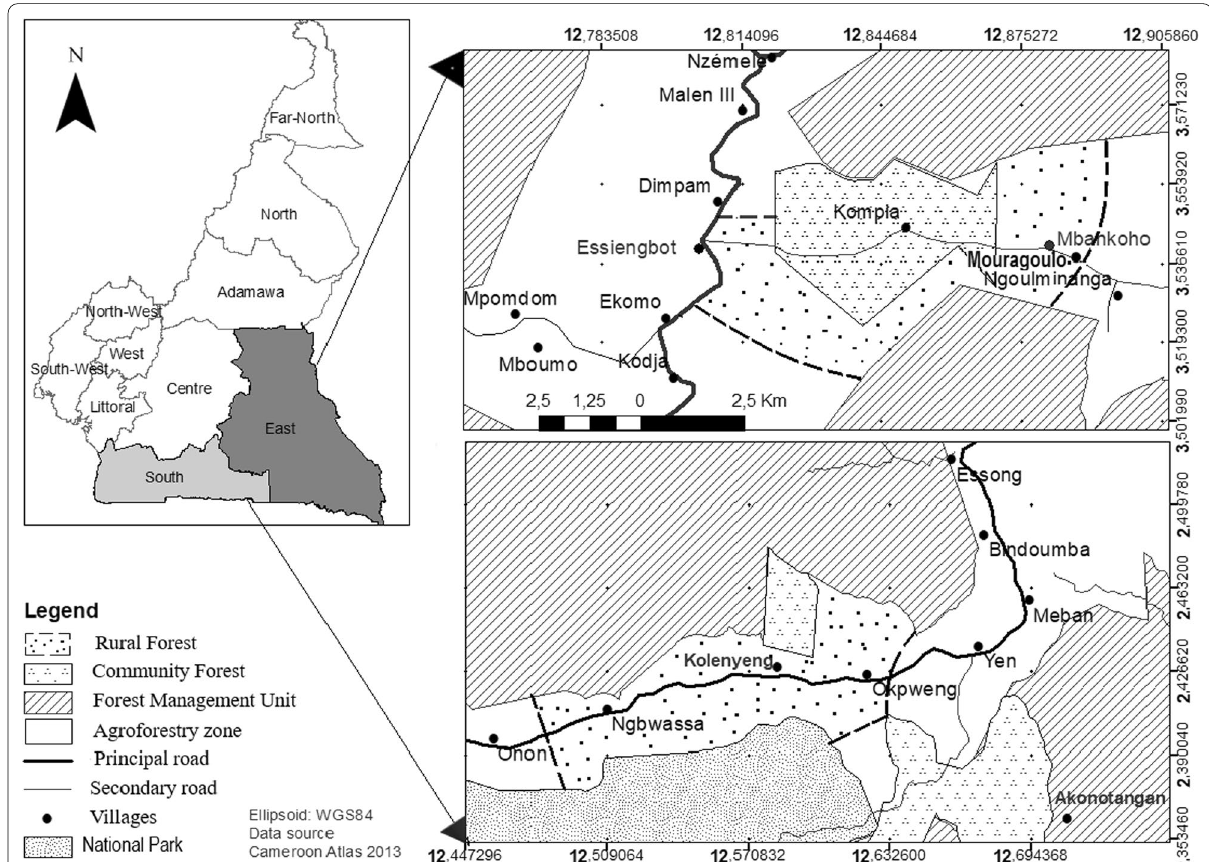
Fig. 1 Map showing the location of the study areas in Cameroon: Essiengbot‑Mbankoho rural forest in the East Region, Nbgwassa‑Opkweng rural forest in the South